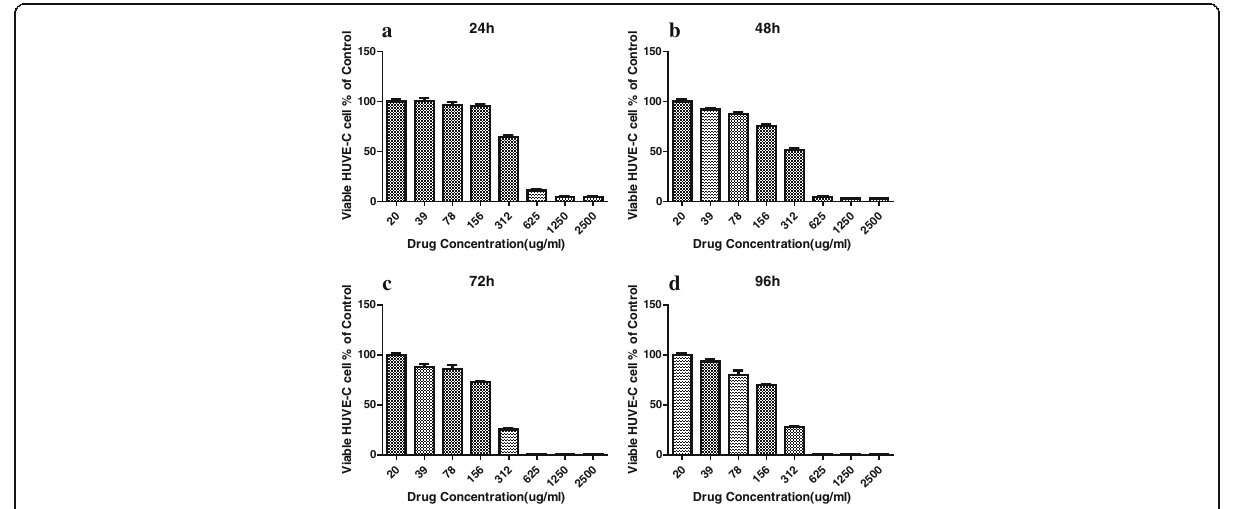
Fig. 1 Effect of oridonin on HUVEC viability. HUVECs were treated with various concentrations (20 – 2500 μ g/ml) of oridonin, and viability was determined by MTT assay at 24, 48, 72, and 96 h. a HUVEC viability at 24 h; b HUVEC viability at 48 h; c HUVEC viability at 72 h; d HUVEC viability at 96 h